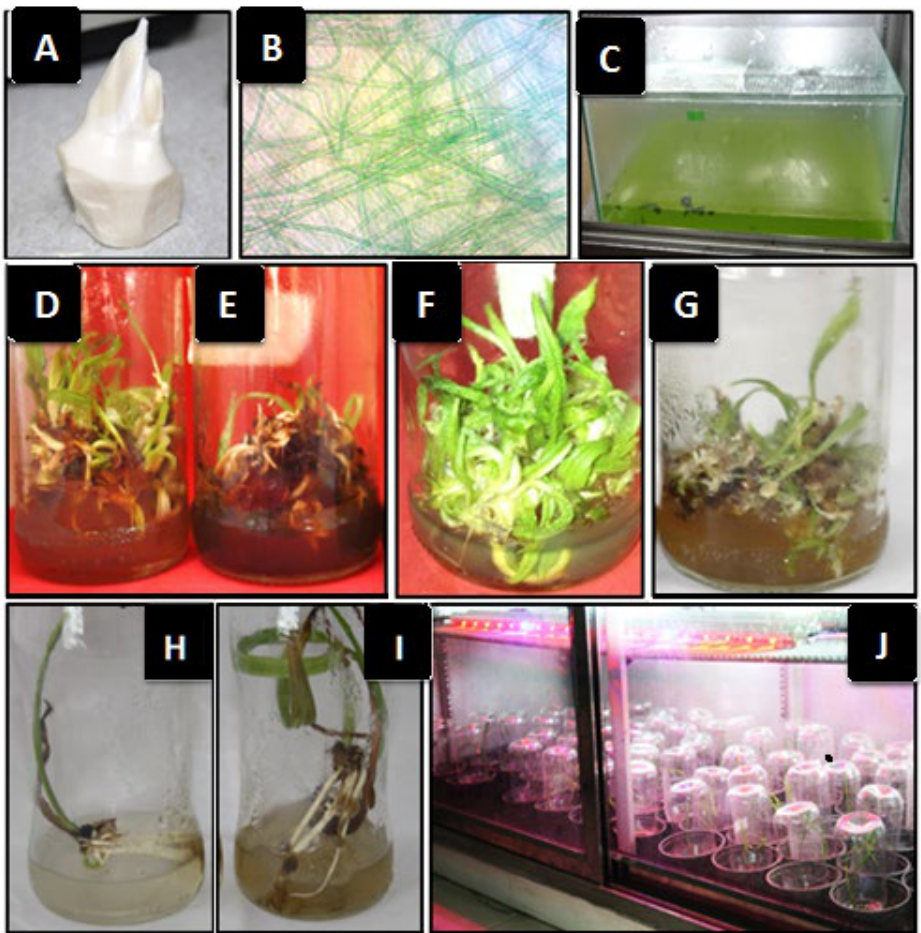
Figure 1. Effect of MS and CEP of algae grown under two different photoperiods on shoot proliferation and rooting of the date palm ‘Barhee’ cultivar in vitro. green algae (20X magnification) supplied with half-strength MS salts and CEP extract CEP extract without MS salts extract of algae that were grown at 16 h day (J) plants